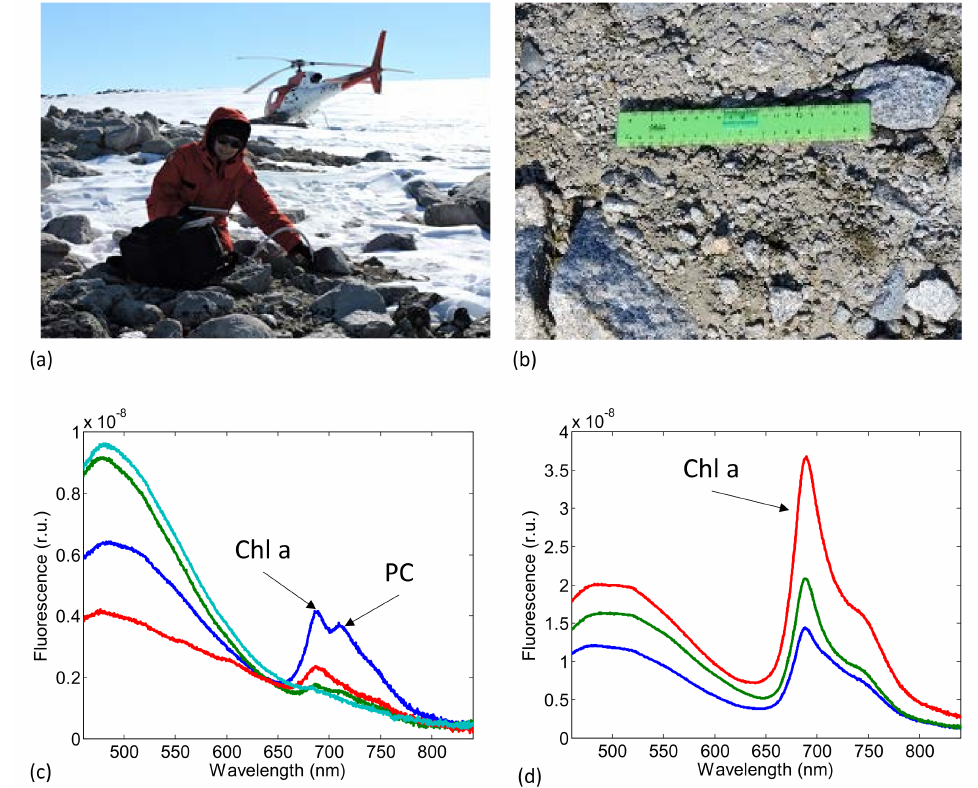
Figure 4. In situ LIF spectra on biological soil crusts acquired during the Antarctic campaign. ( a ) SFIDA–405 prototype during in field operation at Prior Island, Antarctica. ( b ) Terrestrial microbio- logical crust at an early stage of development. ( c ) LIF spectra detected in the field on different points of the crust shown in ( b ). ( d ) LIF spectra on different points of a terrestrial microbiological crust in an advanced stage of development.